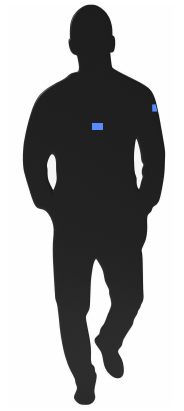
Figure 14. Measured on body placements of the antenna.